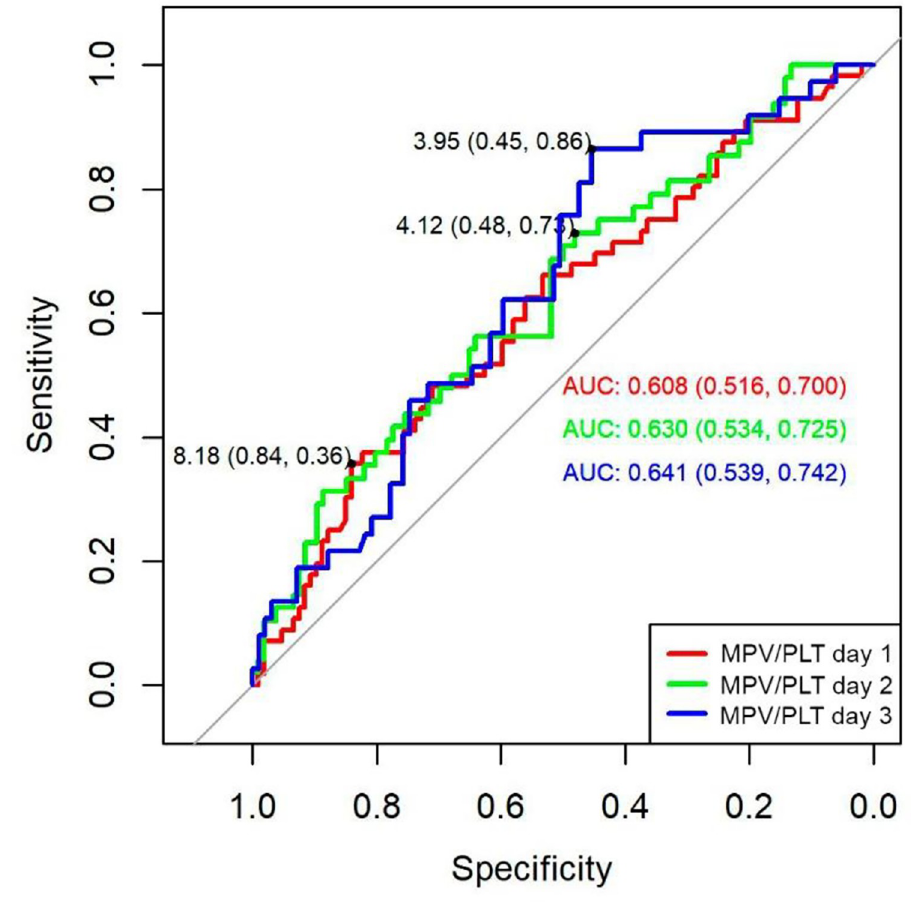
Fig 4. ROC curve of MPV/P ratio to predict the risk of mortality in septic patients. AUC: area under the curve.